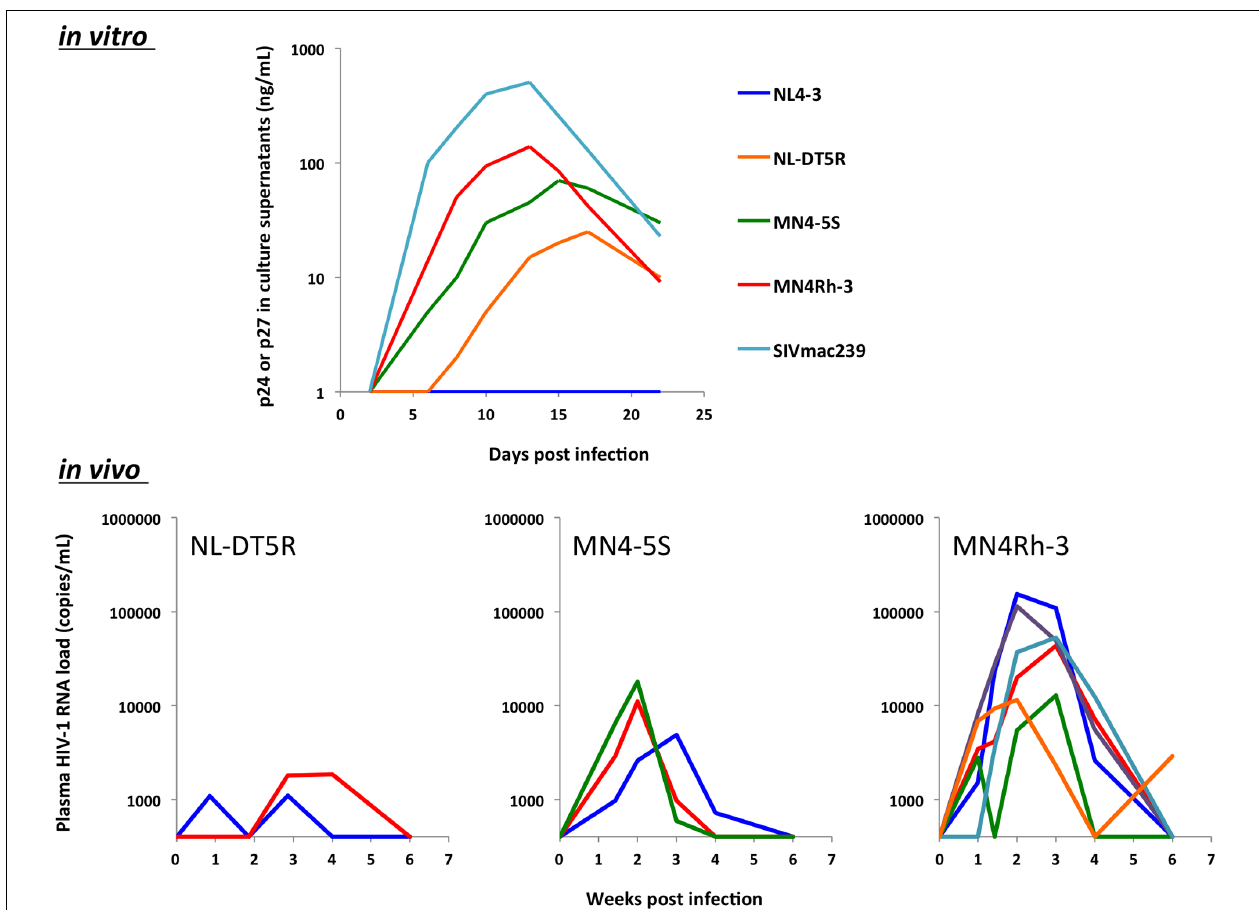
FIGURE 2 | Serial modifications of the viral genome lead to an enhanced viral replication in vitro and in vivo . (Top) CD8 + T cell-depleted peripheral mononuclear blood cells from CMs homozygous for TRIMCyp were infected